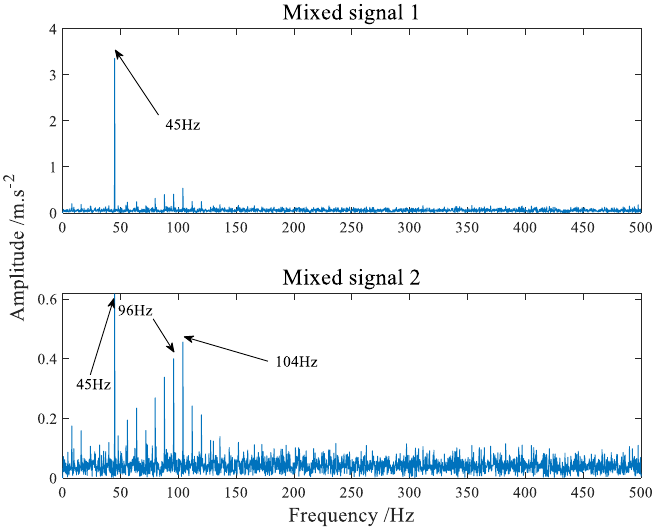
Figure 6. The time − domain waveform of mixed signals.